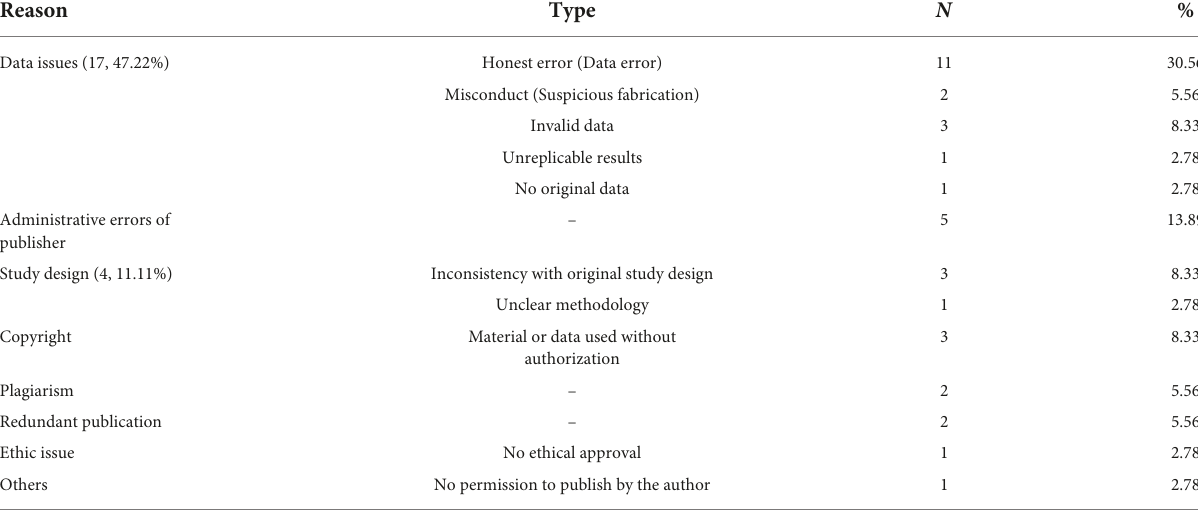
TABLE 3 Reasons for retracted publications on schizophrenia-related studies. Reason Type Data issues (17,